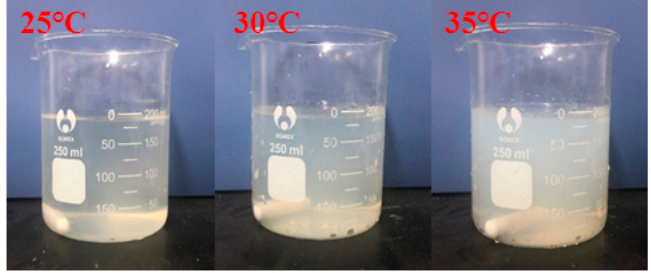
Figure 10. PNBAM aqueous solution graphs at 25, 30, and 35